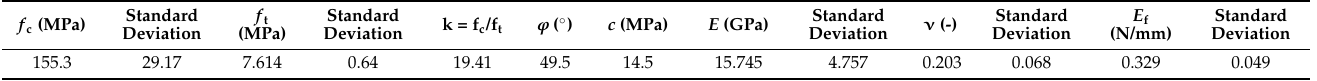
Table 1. The mechanical characteristics of rocks in Braciszów mines.